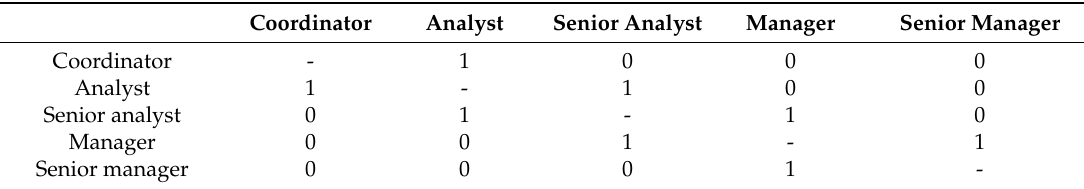
Table 5. Transfer matrix for five available job positions.